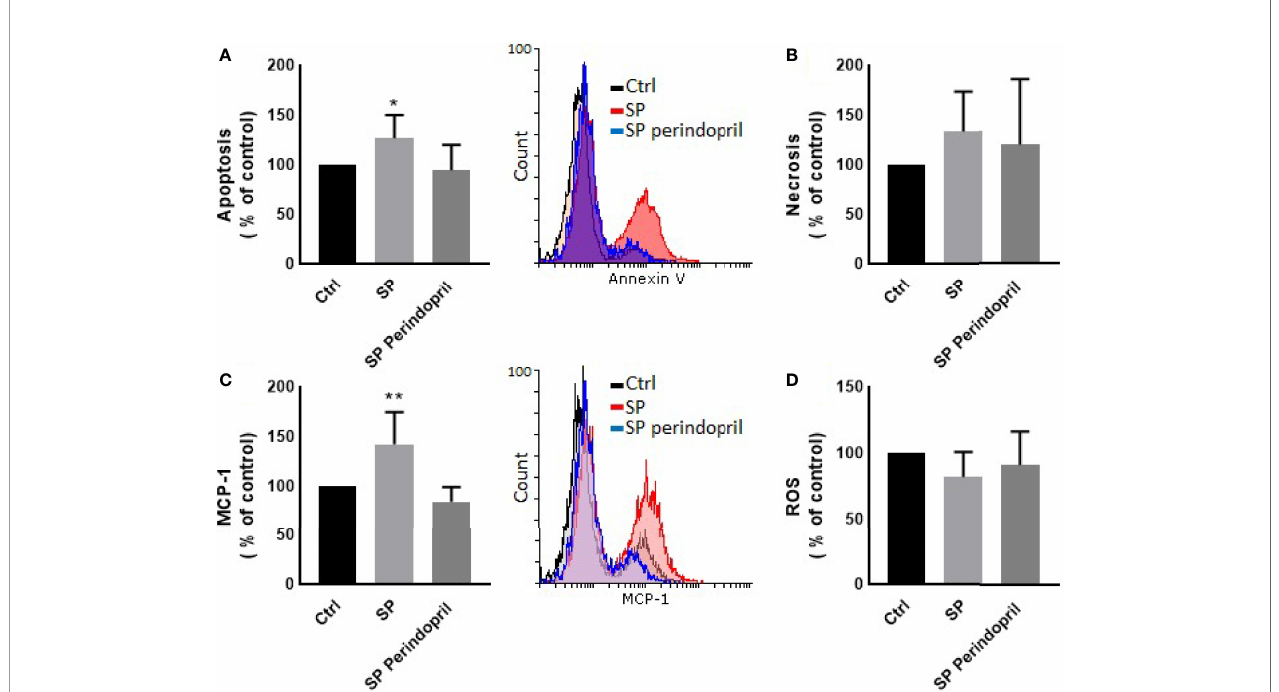
FIGURE 4 | Effects of conditioned media of Thp-1 macrophages cells stimulated with spike (S) protein on HUVEC cells. Thp-1 macrophages were mock treated (Ctrl), stimulated with S protein (SP) (100 µM), or SP with ACE inhibitor (SP Perindopril, 100 µM), perindopril, added 2 h before SP. After 24 h incubation, conditioned media (CM) was collected and used for HUVEC cell culture. (A) Apoptosis was measured by Annexin V binding essay. (B) Necrosis detection was evaluated by internalization of propidium iodide (PI). (C) Monocyte chemoattractant protein-1 (MCP-1) expression. (D) ROS detection was measured by fl ow cytometry. The data are presented as mean ± SEM, n = 4. Ordinary one-way ANOVA followed by Dunnett ’ s test: * p < 0.05, ** p <